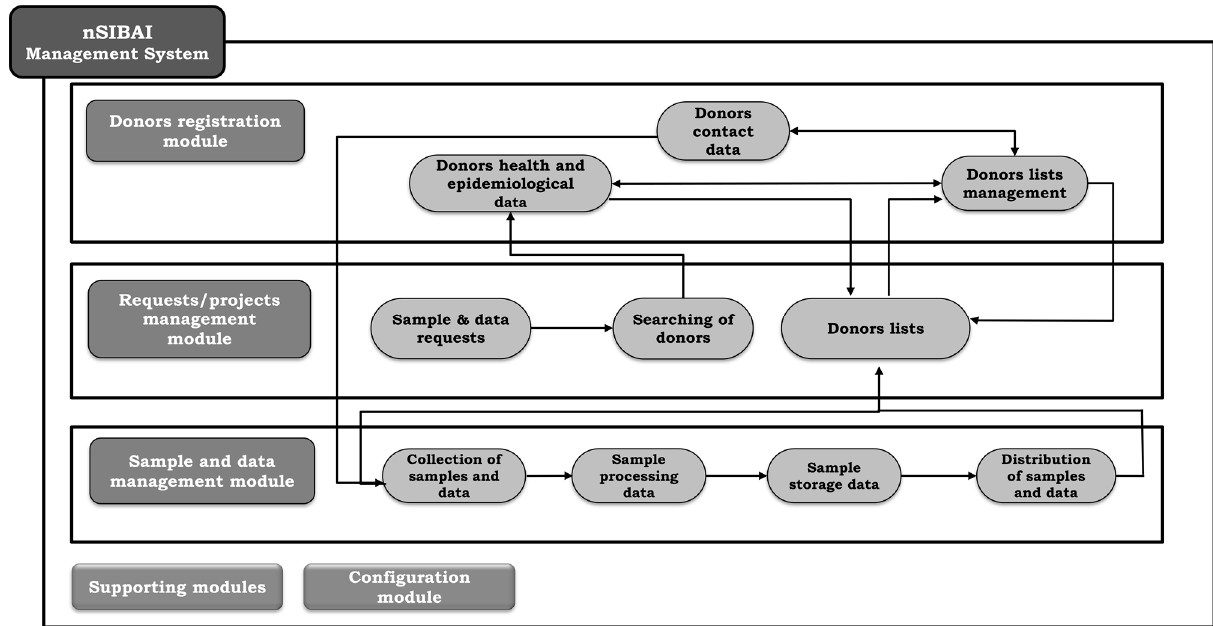
Figure 2. Interaction of the nSIBAI modules including the specific module for the Andalusian Registry of Donors for Biomedical Research.